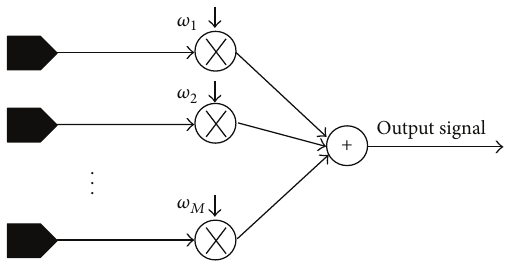
Figure 1: Diversity combining block